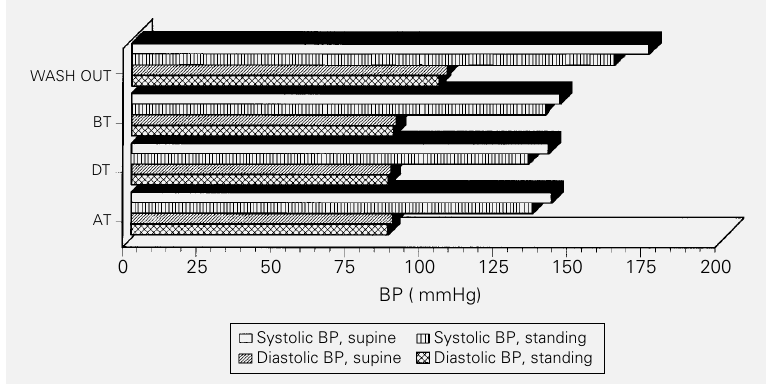
Figure 1 - Systolic and diastolic blood pressure (BP) levels during the study. WASH OUT, Without antihypertensive treatment; BT, before estrogen treatment; DT, during estrogen treatment; AT, 2 months after hormone treatment was